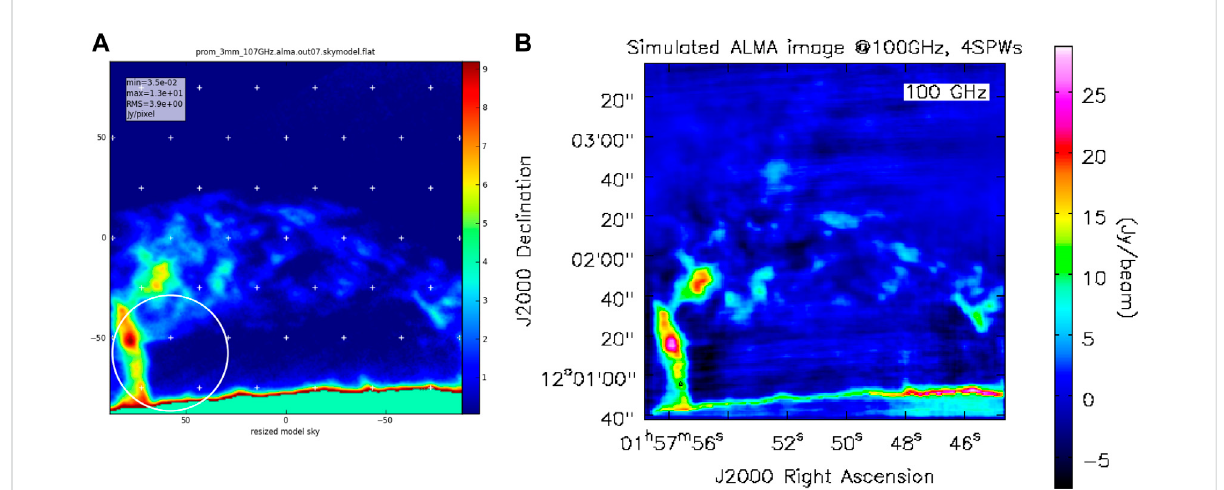
FIGURE 1 (A) :Modelled(ideal)brightnesstemperaturemapat100 GHz.ThewhitecircleshowsALMA fi eld-of-viewforsinglepointing,thecrossesarethe centresofpointingforinterferometricmosaic.Fourty-ninepointingsarenecessaryforNyquistsamplingofthedisplayedpartoftheprominence. (B) : Corresponding image as seen by ALMA at 3 mm in Band 3 simulated with the CASA: simobserve () task. Reproduced from Heinzel et al.